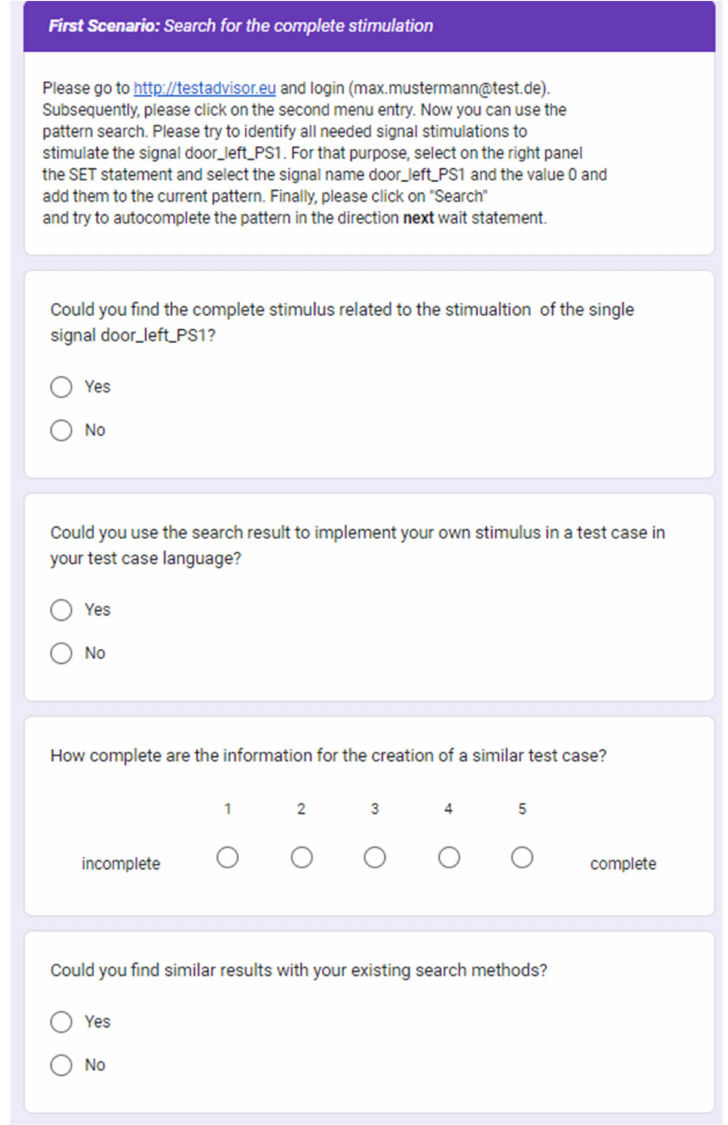
Figure 19. Page one from the